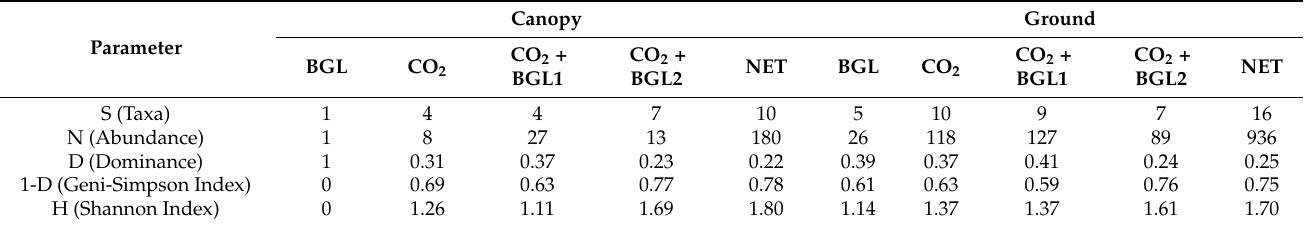
Table 2. Indicators of abundance, richness, diversity, and dominance of Culicidae specimens collected in the “P é -do-Gigante” sector of the Vassununga State Park, by forest strata, technique, and attractant. Next page.